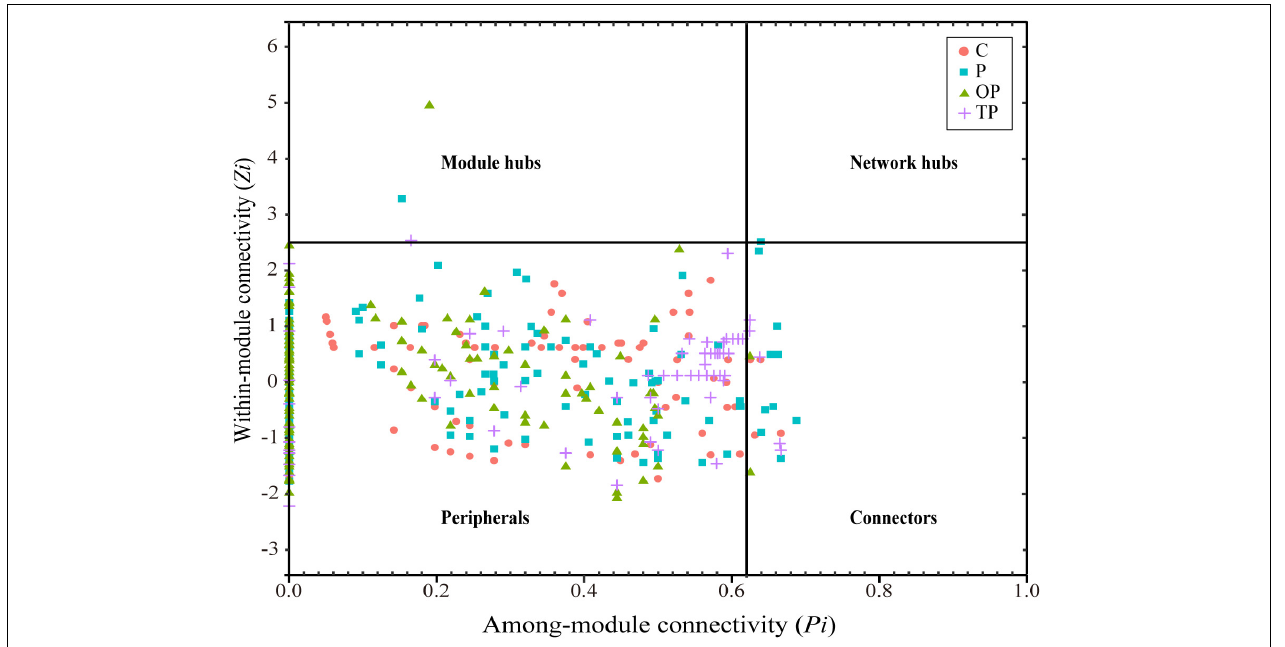
FIGURE 8 | Distribution of sea cucumber intestinal bacterial taxa based on their topological roles. C (control): basal diet; P: basal diet supplementation with 0.5% PHB; OP: basal diet supplementation with 1% PHB; TP: basal diet supplementation with 3%